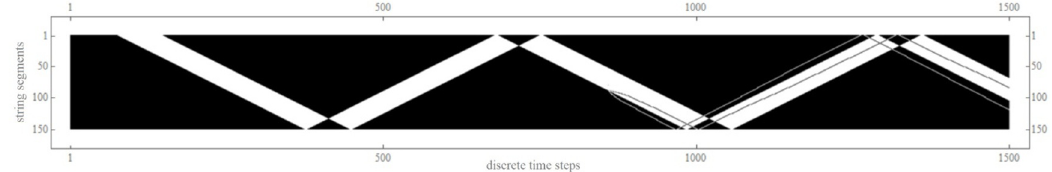
Figure 12 . The collision of two kinks on the segmented string worldsheet generates a deficit angle. The sign of the angle selects the local type of the equation of motion (shG or chG).